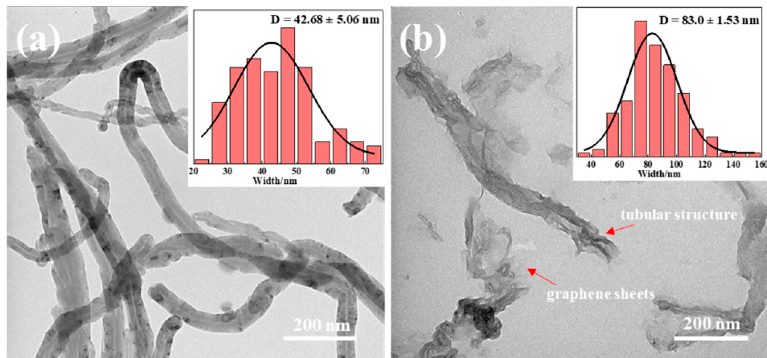
Figure 2. TEM images of ( a ) pristine MWCNTs, and ( b ) uMWCNTs.